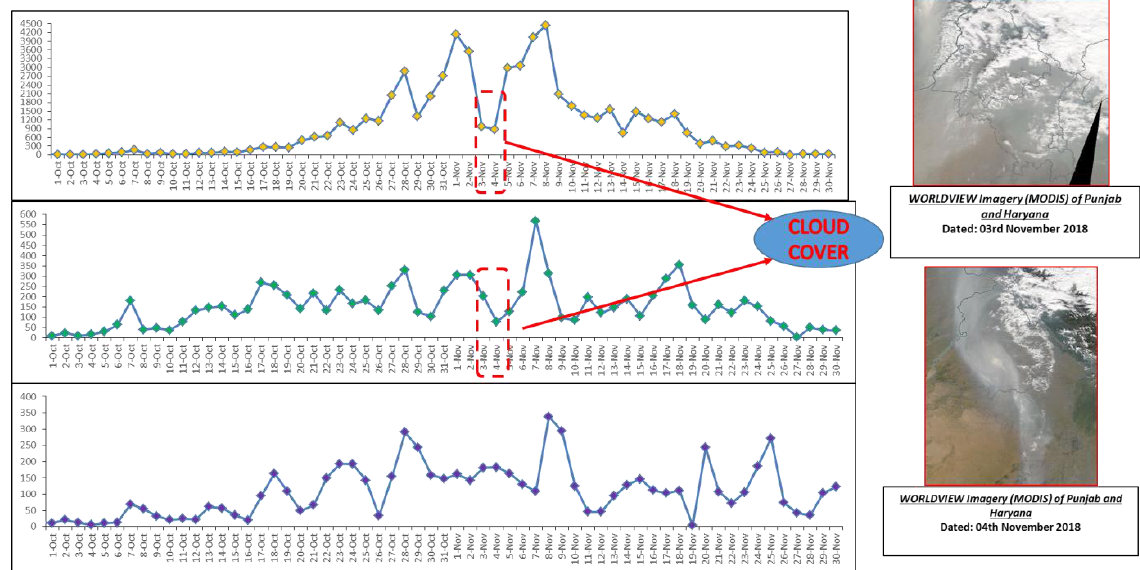
Figure 5. Temporal distribution of active fire events during the monitoring period in 2018. (Yellow: Punjab; Green: Haryana; Purple: Uttar